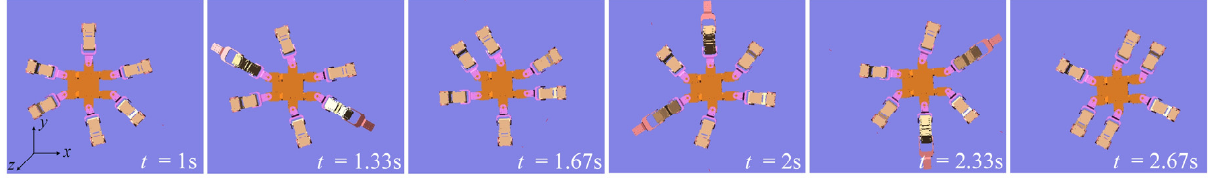
Figure 8. The simulation screenshots of the tetrapod gait.